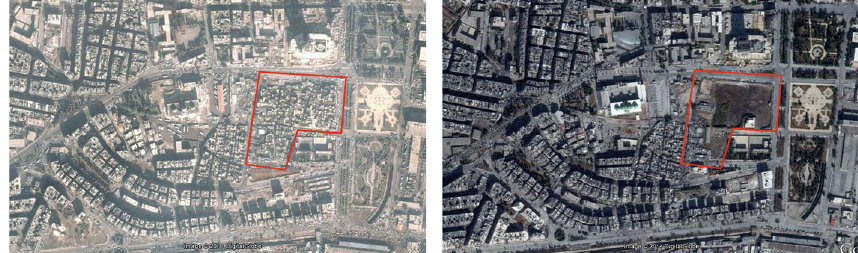
Fig. 13 Satellite Images from 2000 and 2004 Showing a Large Bulldozed Area in the Remains of the Historic Al-Masharika Quarter (Source: Google